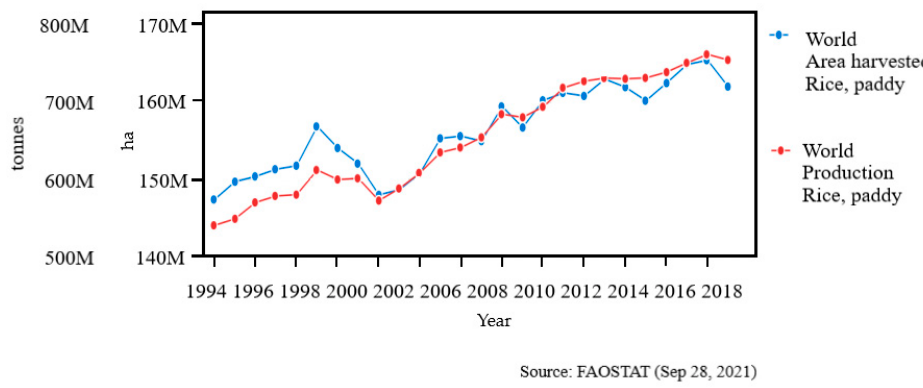
Figure 1. Production/yield quantities of rice paddy in the world (1994–2019) [2].